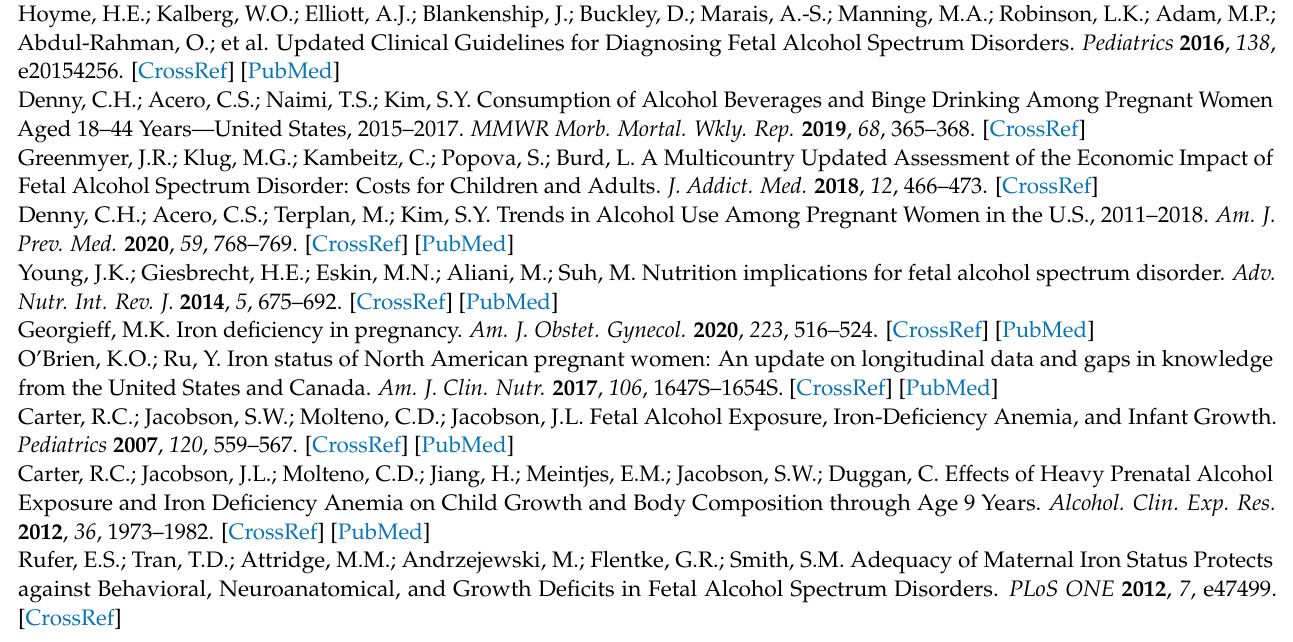
S2: Maternal feces 24-h mineral content; Table S3: Maternal liver mineral content; Table S4: Fetal liver mineral content; Table S5: Fetal brain mineral